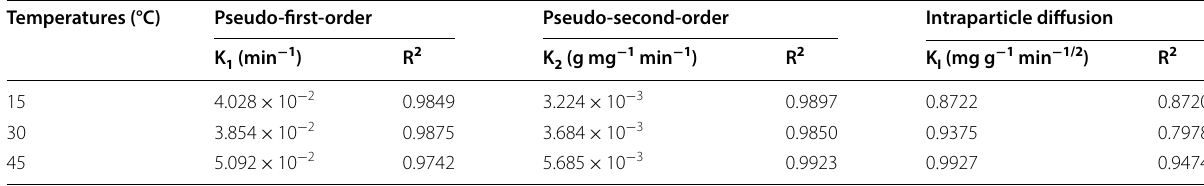
Table 1 Kinetic model parameters for adsorption of fluoride Temperatures (°C)